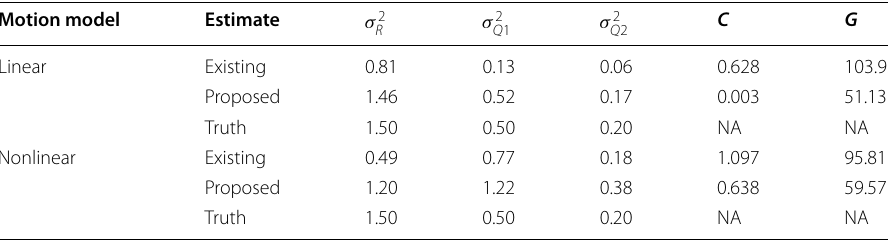
Table 3 Average variance estimates and localization errors, from simulations with n = 20 Motion